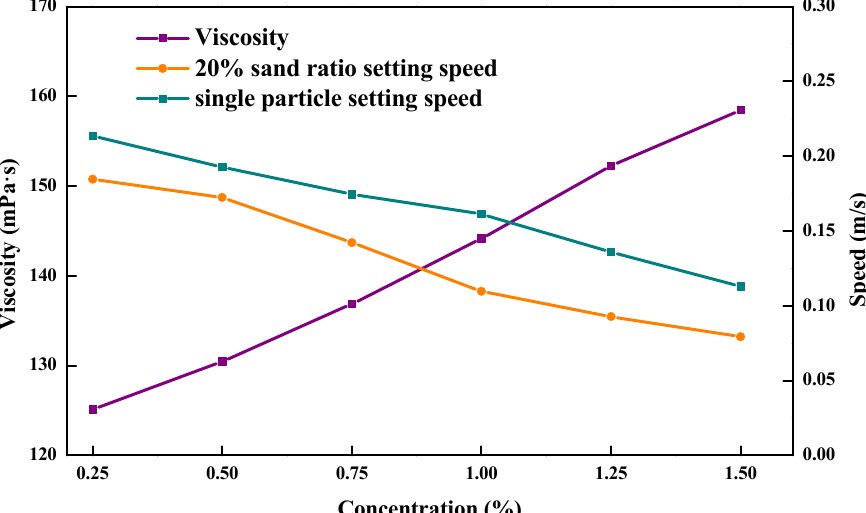
Figure 13. Relationships between the concentration of conventional guar fracturing fluid and the sedimentation rate and viscosity.